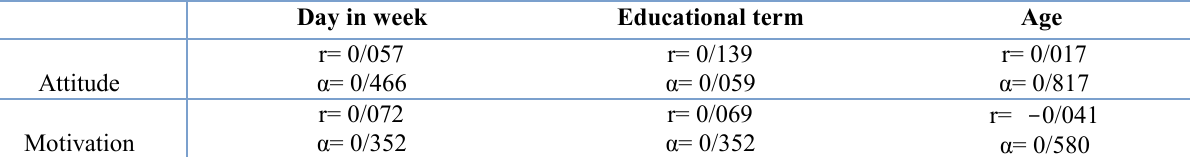
Table 2: relationship between attitude and motivation with variables of age, educational term, number of exercise days